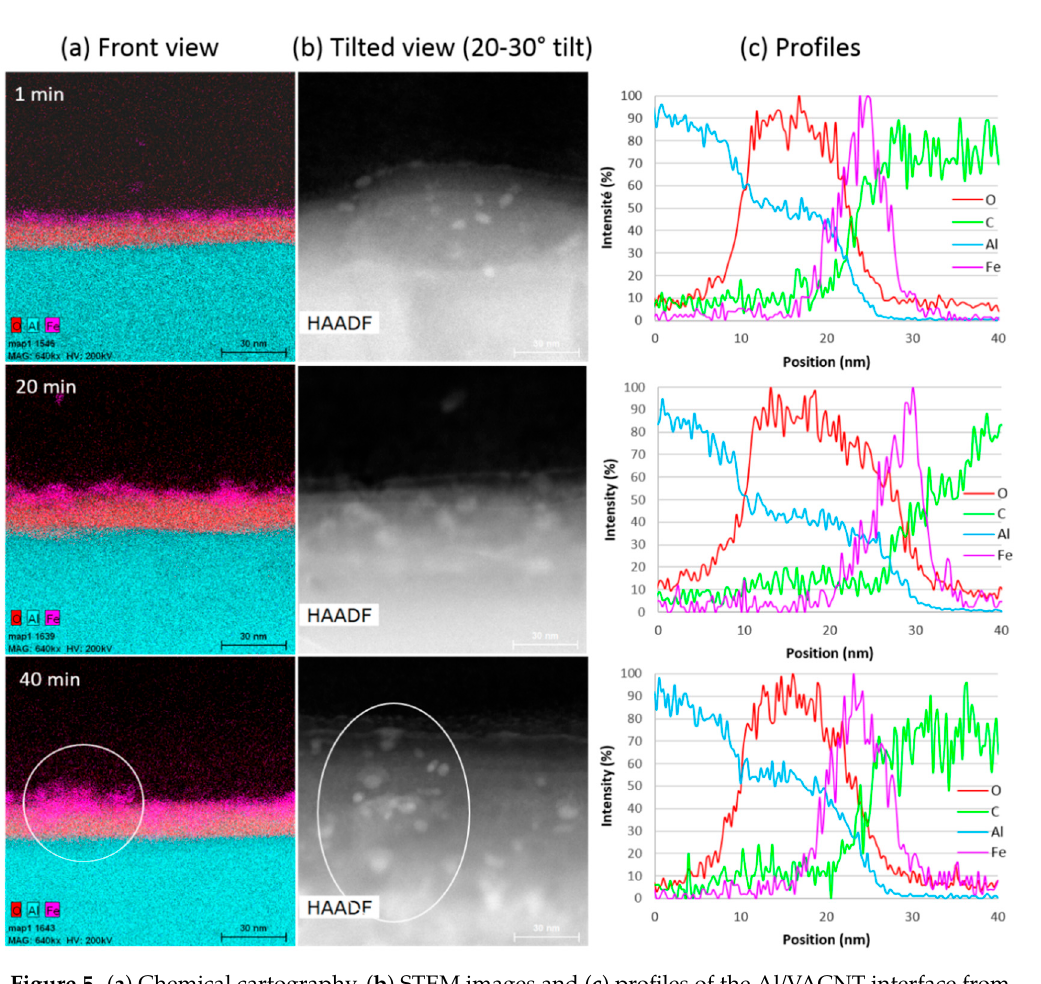
Figure 5. ( a ) Chemical cartography, ( b ) STEM images and ( c ) profiles of the Al/VACNT interface from syntheses at 580 °C of 1, 20 and 40 min duration, respectively (all images are at the same